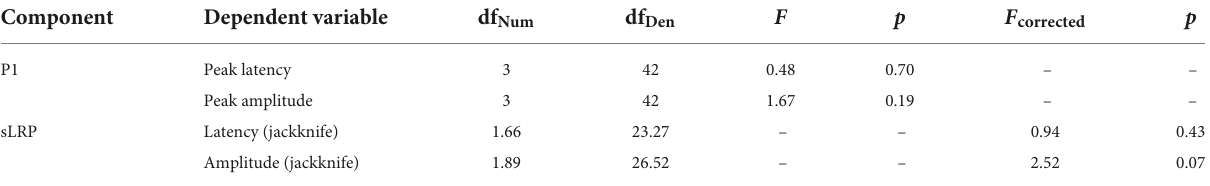
TABLE 4 Non-significant results of the repeated measure analysis of variance (rmANOVA) conducted for the event-related potential (ERP) components.